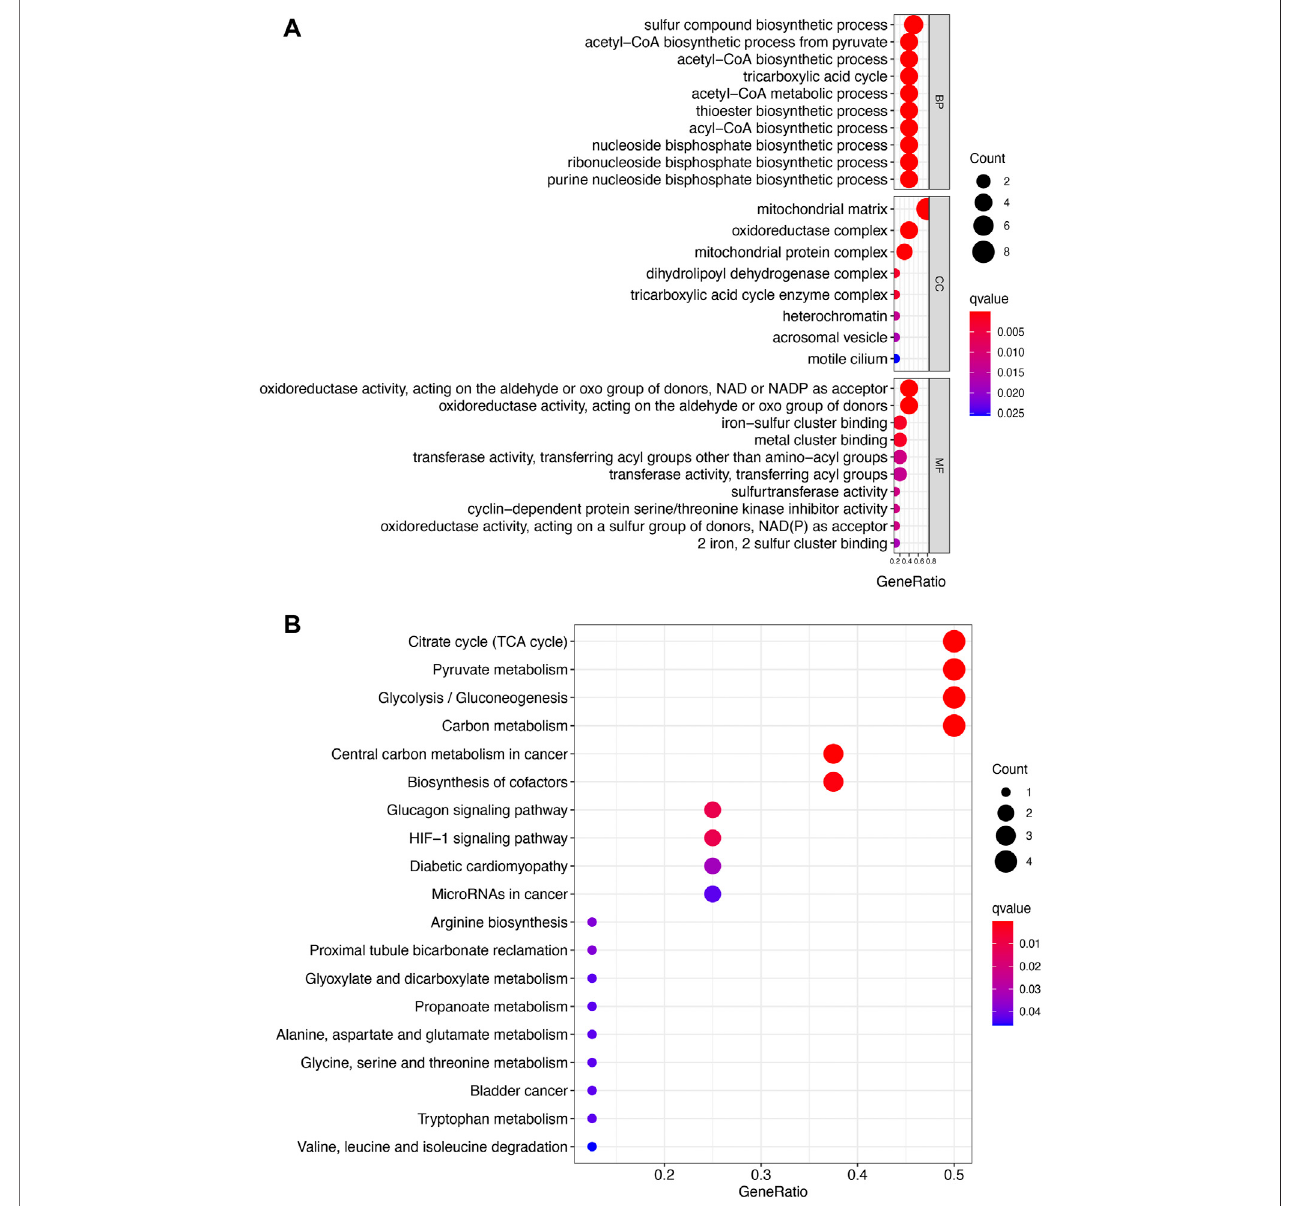
FIGURE3 | Enrichment analysis ofcuproptosis-related genes in uterine corpus endometrial carcinoma. (A) Enriched items in geneontology analysis. (B) Enriched items in Kyoto Encyclopedia of Genes and Genomes. BP, biological process; CC, cellular component; MF molecular function.